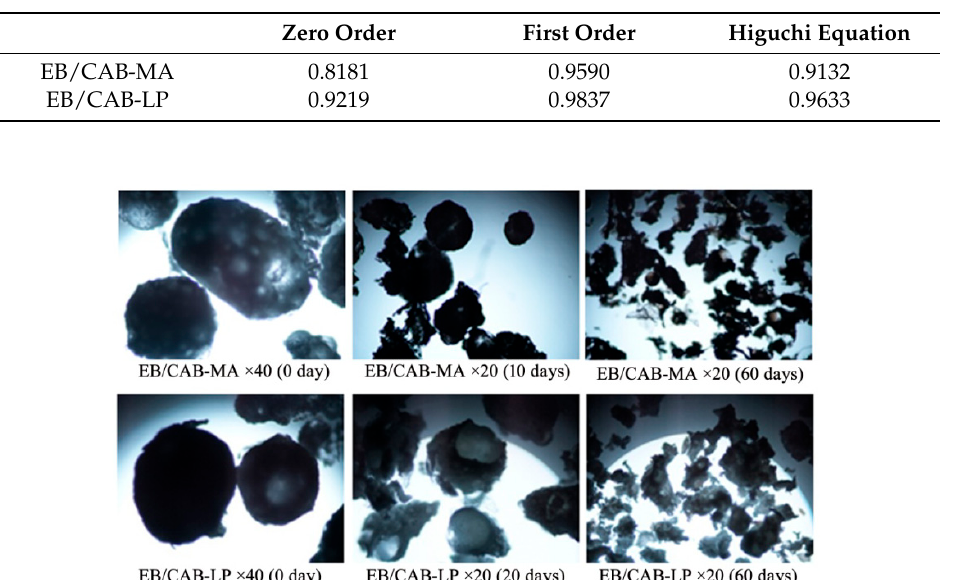
Figure 8. Releasing rate of EB from EB/CAB-MA and EB/CAB-LP microspheres ( n = 3). Table 3. R values of all models for releasing EB from EB/CAB-MA microspheres and EB/CAB-LP microspheres.